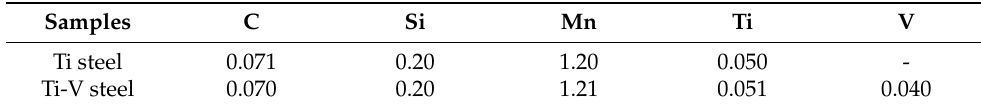
Table 1. Main chemical composition of experimental steel